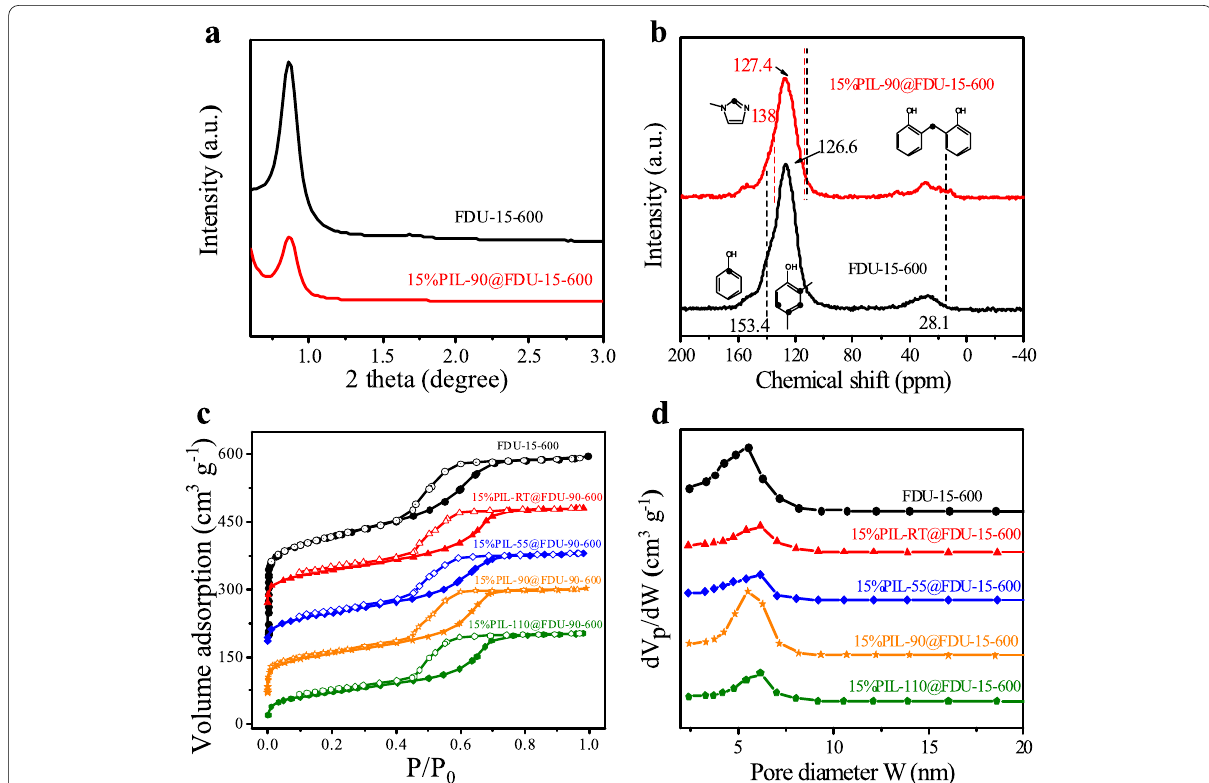
Fig. 1 a Small-angle XRD patterns. b Solid-state 13 C CP/MAS NMR spectra. c Nitrogen sorption isotherms and d pore size distribution curves. The sorption isotherms for samples FDU-15-600, 15%PILRT@FDU-15-600, 15%PIL-55@FDU-15-600, and 15%PIL-90@FDU-15-600 are shifted by 200, 250, 160,and 70 cm 3 g -1 . The pore size distribution curves for samples FDU-15-600, 15%PIL-RT@FDU-15-600, 15%PIL-55@FDU-15-600, and 15%PIL-90@ FDU-15-600 are shifted by 0.7, 0.55, 0.4, and 0.15 cm 3 g -1 ,